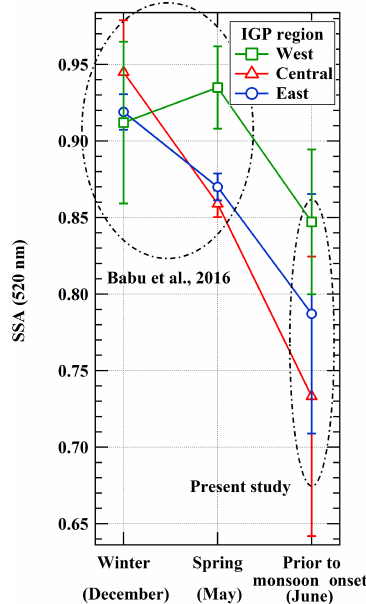
Figure 6. Seasonal variation of columnar (500–3000m) SSA over different regions of the IGP: western (square), central (triangle) and eastern (circle). Values in the upper-left circle are calculated from Babu et al.